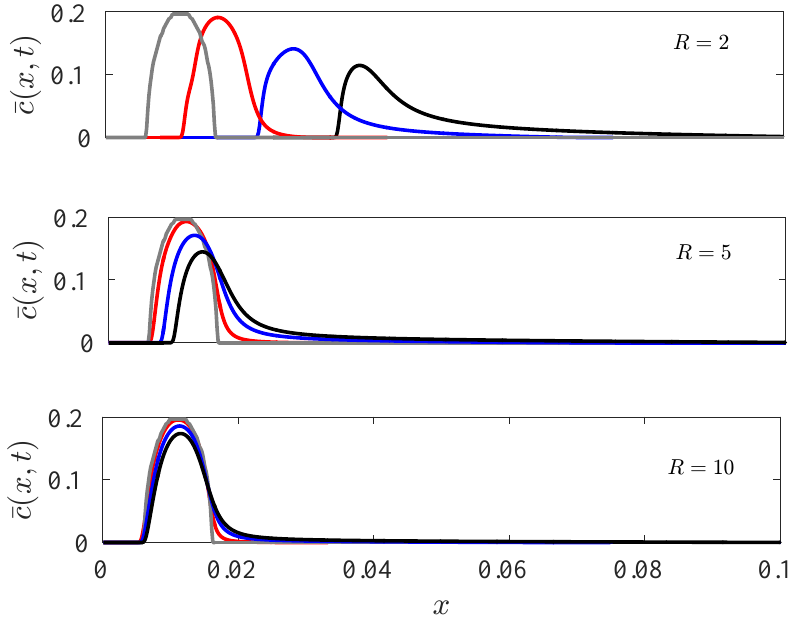
Figure 3. Transversely averaged concentration for different R (mentioned in each subfigure) in fixed reference frame at time t = 0 (gray), 20 (red), 60 (blue), and 100 (black)